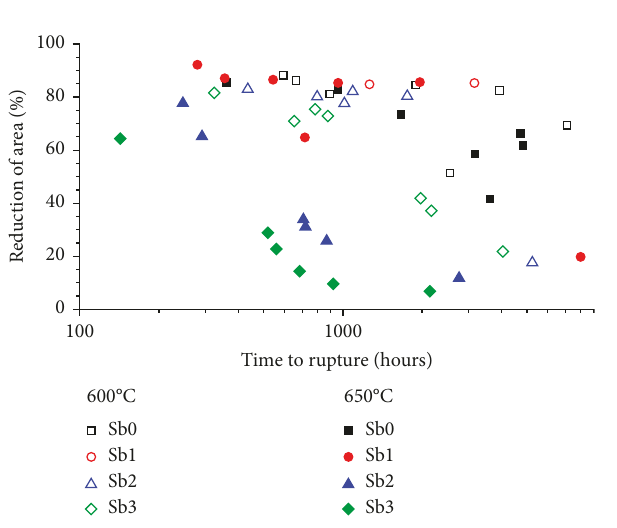
Figure 6: Analysis of Grade 91 behavior for experimental heats doped with Sb and tested at 600 ° C (1112 ° F) and 650 ° C (1202 ° F). Adapted from [27]. For even the heats with the low levels of Sb (Sb1 0.011 weight percent), there was a marked drop in the (cid:31) measured creep ductility, this drop was accelerated with increasing levels of